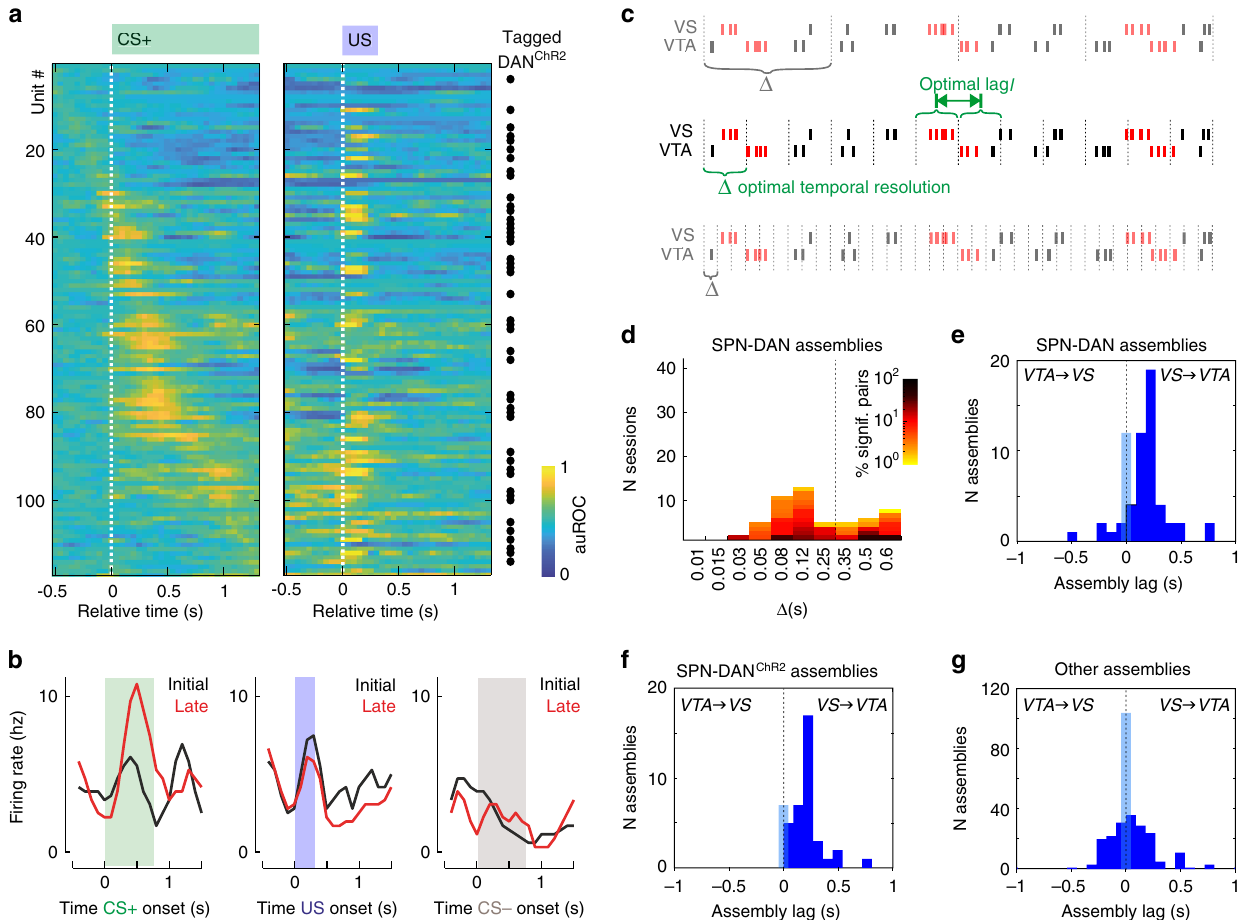
Fig. 4 SPN lead DAN activation. a Response traces of putative DAN computed with a sliding-window auROC (response vs. baseline). The distribution of optogenetically tagged neurons supports the classi fi cation of DAN. b , Mean activity for the ‘ initial ’ 12 vs. ‘ late ’ 12 trials of the original phase of an exemplary DAN. The plots show an increase in fi ring at CS + and decrease at US with learning (moving average smoothing over three adjacent bins). c Scheme illustrating assembly detection of interregional assembly (marked in red) with sequential activation. The lag ( l ) measures the delay between the activation of the units composing the assembly. The temporal resolution ( Δ ) captures the temporal precision/duration of unit activity when fi ring within the assembly. d Distribution of the temporal resolutions of the 359 detected SPN – DAN assemblies. The percentage of signi fi cant pairs of all possible pairs for each session is color-coded. SPN – DAN pairs had two characteristic time scales. e – g Distribution of inter-unit activation lags of assemblies with Δ <250ms. Positive lags indicate that the VTA unit followed the activation of the VS unit (and vice versa). Directionality was observed for ( e ) the 63 SPN – DAN and ( f ) 43 SPN – DAN ChR2 assemblies, in contrast to ( g ) 296 assemblies composed of other cell types. Source data are provided as a Source data fi le. See also Supplementary Figs.